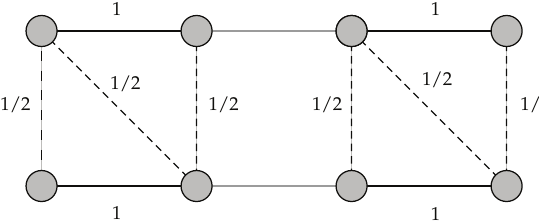
Figure 1: LP-solution that does not contain a cycle w.r.t. Inequalities (cid:2) 3.15 (cid:3) , but still violates subtour elimination constraints. Corresponding (cid:2) integer (cid:3) label solutions are not necessarily